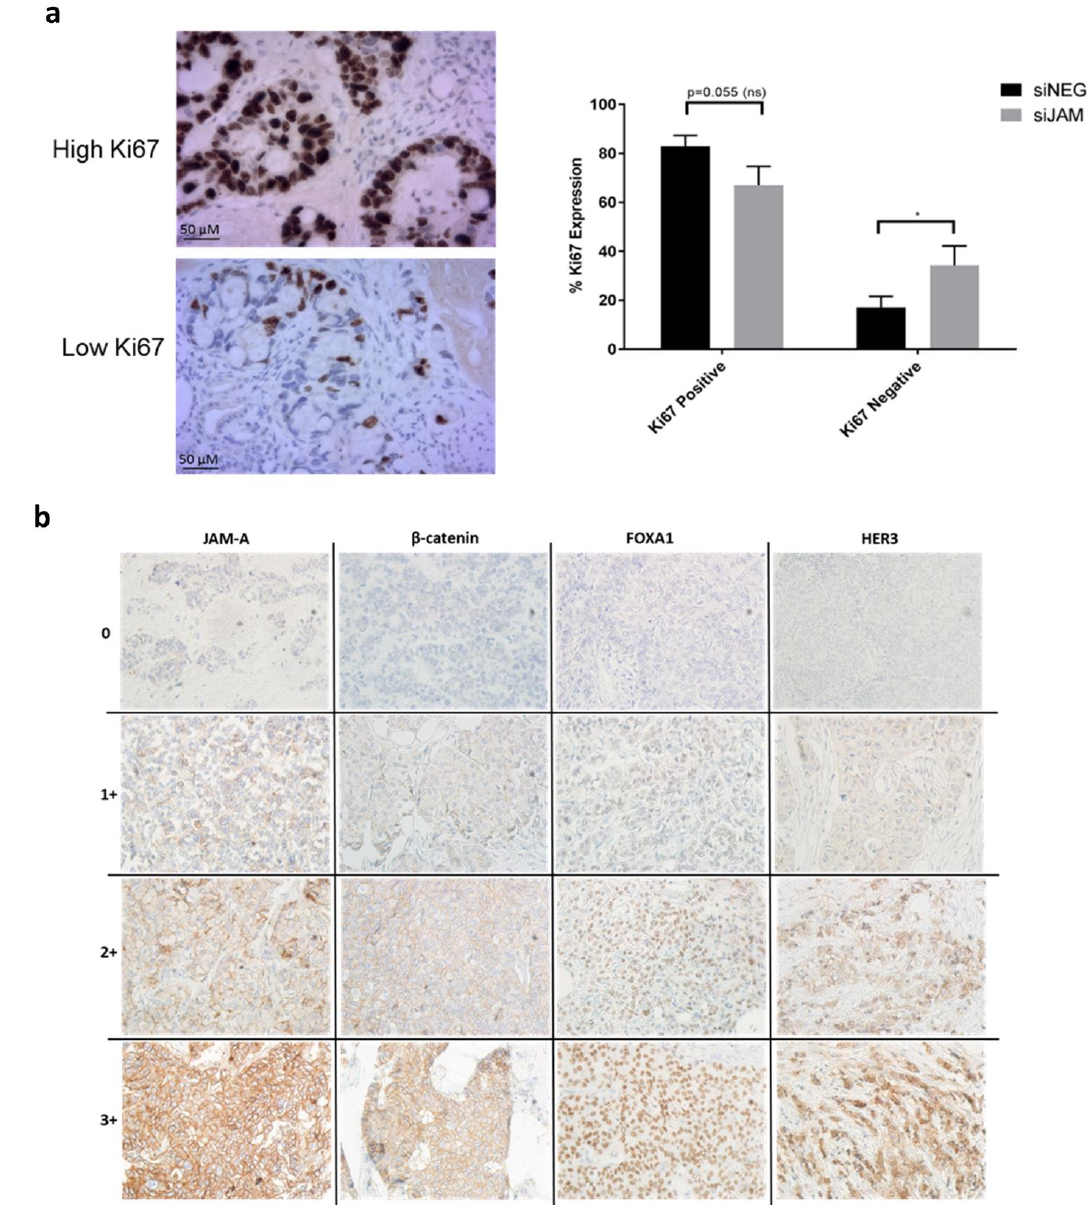
Figure 6. JAM-A is associated with tumor cell proliferation and other oncogenes in higher order models. ( a ) Images – representative high and low Ki67 staining from different tumor xenograft samples. Graph – Quantification of Ki67 in 500 cells revealed that JAM-A silencing was associated with a higher number of Ki67-negative cells, resting cells, compared to control conditions. Data represent mean ± s.e.m, compared using one-tailed, equal variance Student’s t-tests, * p < 0.05. ( b ) Representative images at 10X magnification illustrating 0, 1+, 2+ and 3+ JAM-A, β -catenin, FOXA1 and HER3 scoring intensities in a tissue microarray constructed from invasive breast cancer patient specimens. JAM-A expression was predominantly membranous with some cytosolic expression. β -catenin was mostly present in the cytoplasm and/or membrane but occasionally in the nucleus. FOXA1 expression was predominantly nuclear. HER3 expression was both membranous and